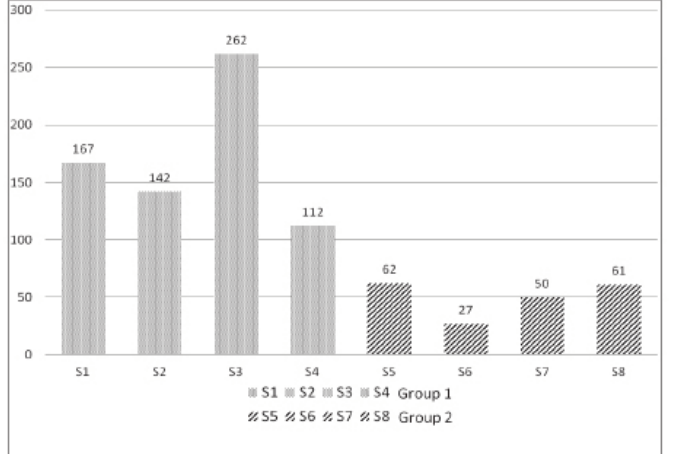
Figure 3. Frequencies ofstudent SPT roles summed across all time